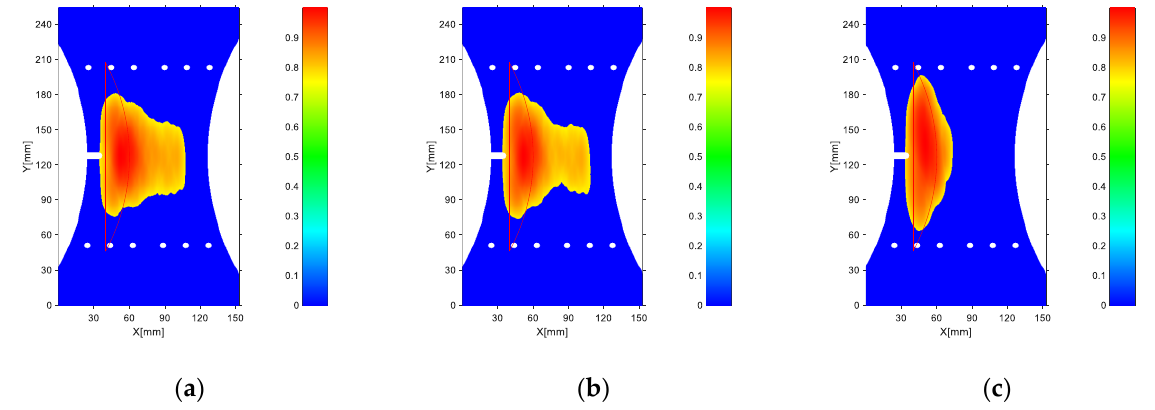
Figure 17. Thresholded imags for different damage factors at 90,000 fatigue cycles: ( a ) energy damage factor; ( b ) cross-correlation damage factor; ( c ) sparse representation damage factor.